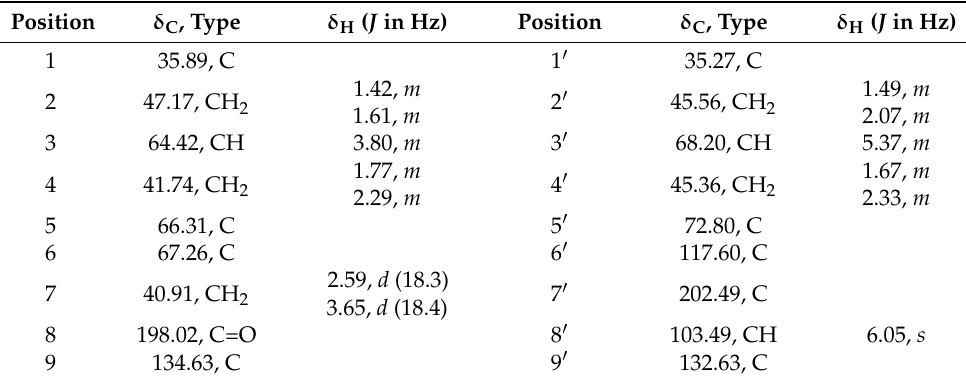
Table 1. 1 H and 13 C NMR spectral data of purified fucoxanthin recorded in CDCl 3 at 400 MHz and 100 MHz respectively .